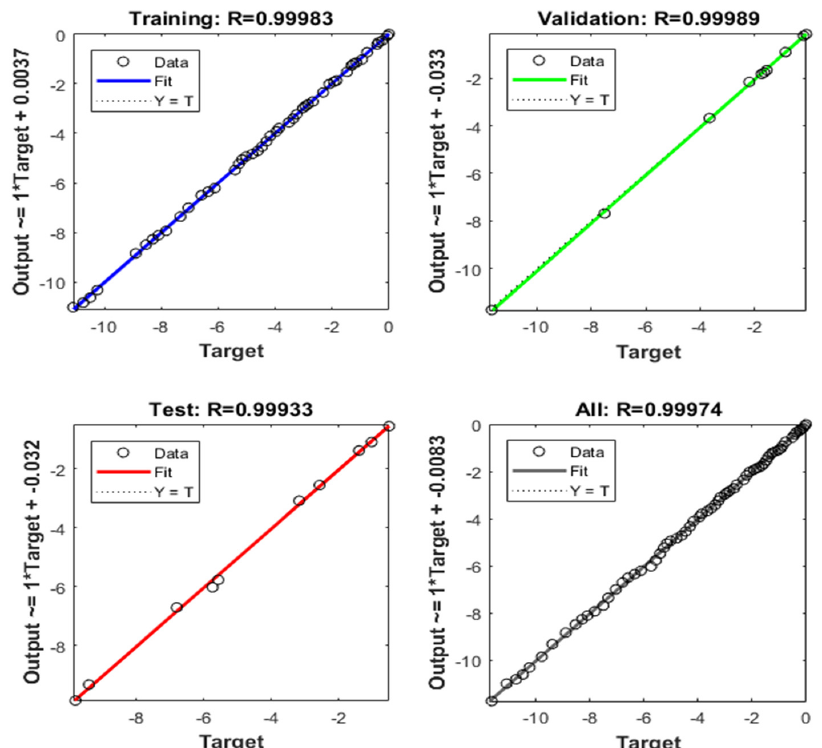
Figure 10. Prediction of the load vs. displacement relationship using ANN and using experimental observation for the training, validation, testing, and all datasets (BRC-3).